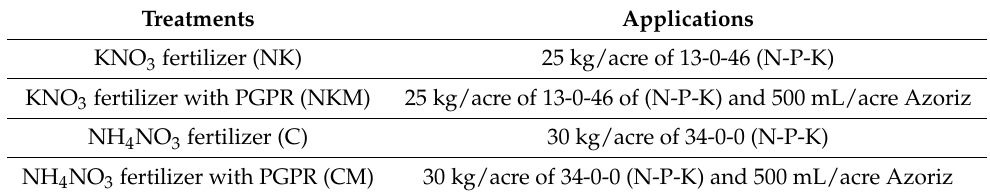
Table 2. Details regarding the applications that were performed on each treatment group.